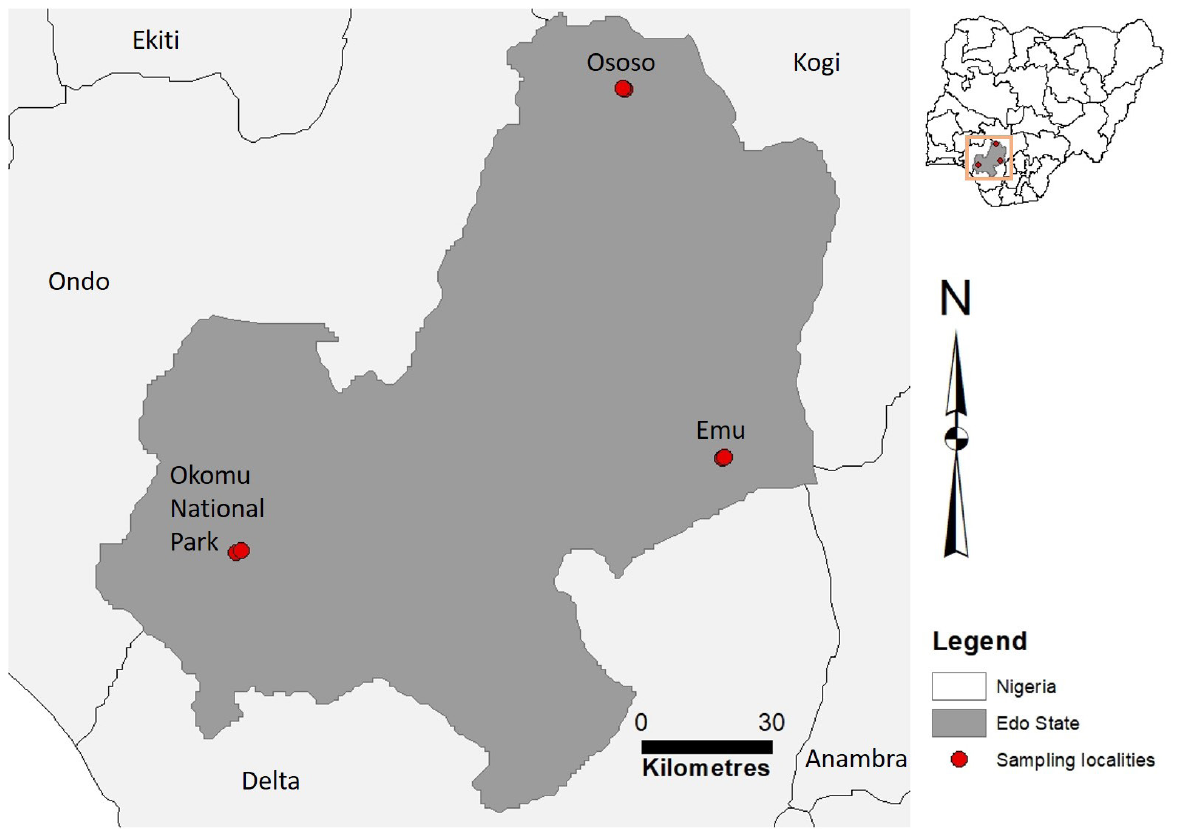
Figure 1. Study localities. Insert: Nigeria, showing spatial extent of surveyed